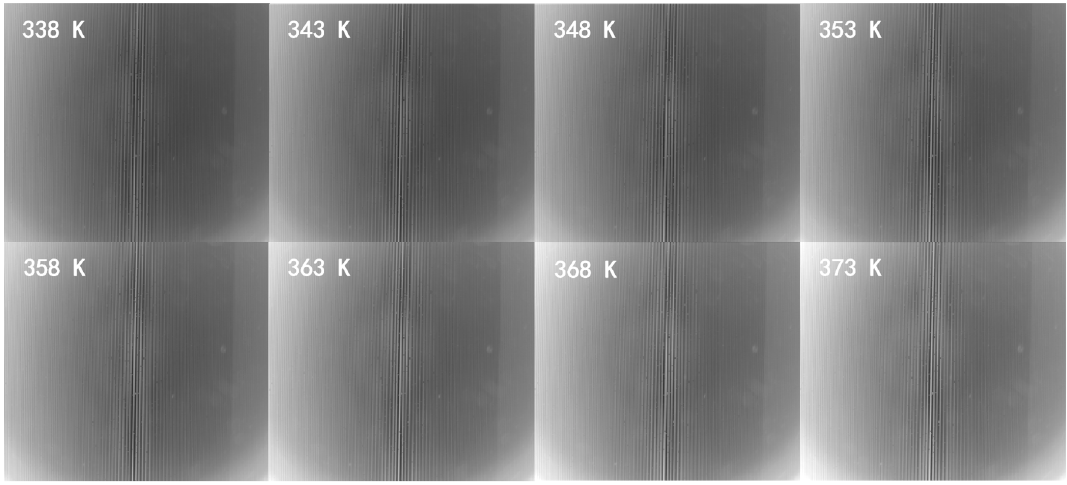
Figure 10. Interferograms of flat field radiation source in 338 K–373 K.